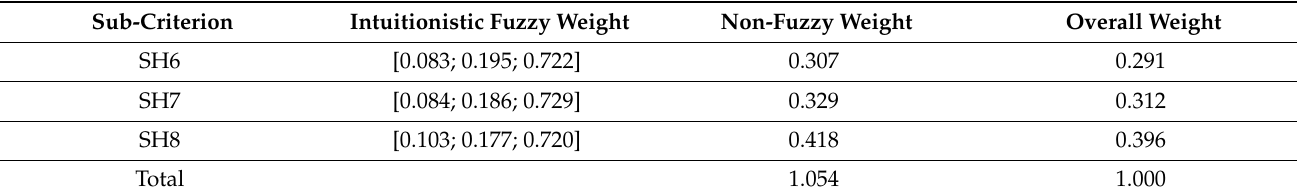
Table 3. Intuitionistic and normalized weights—healthcare equipment